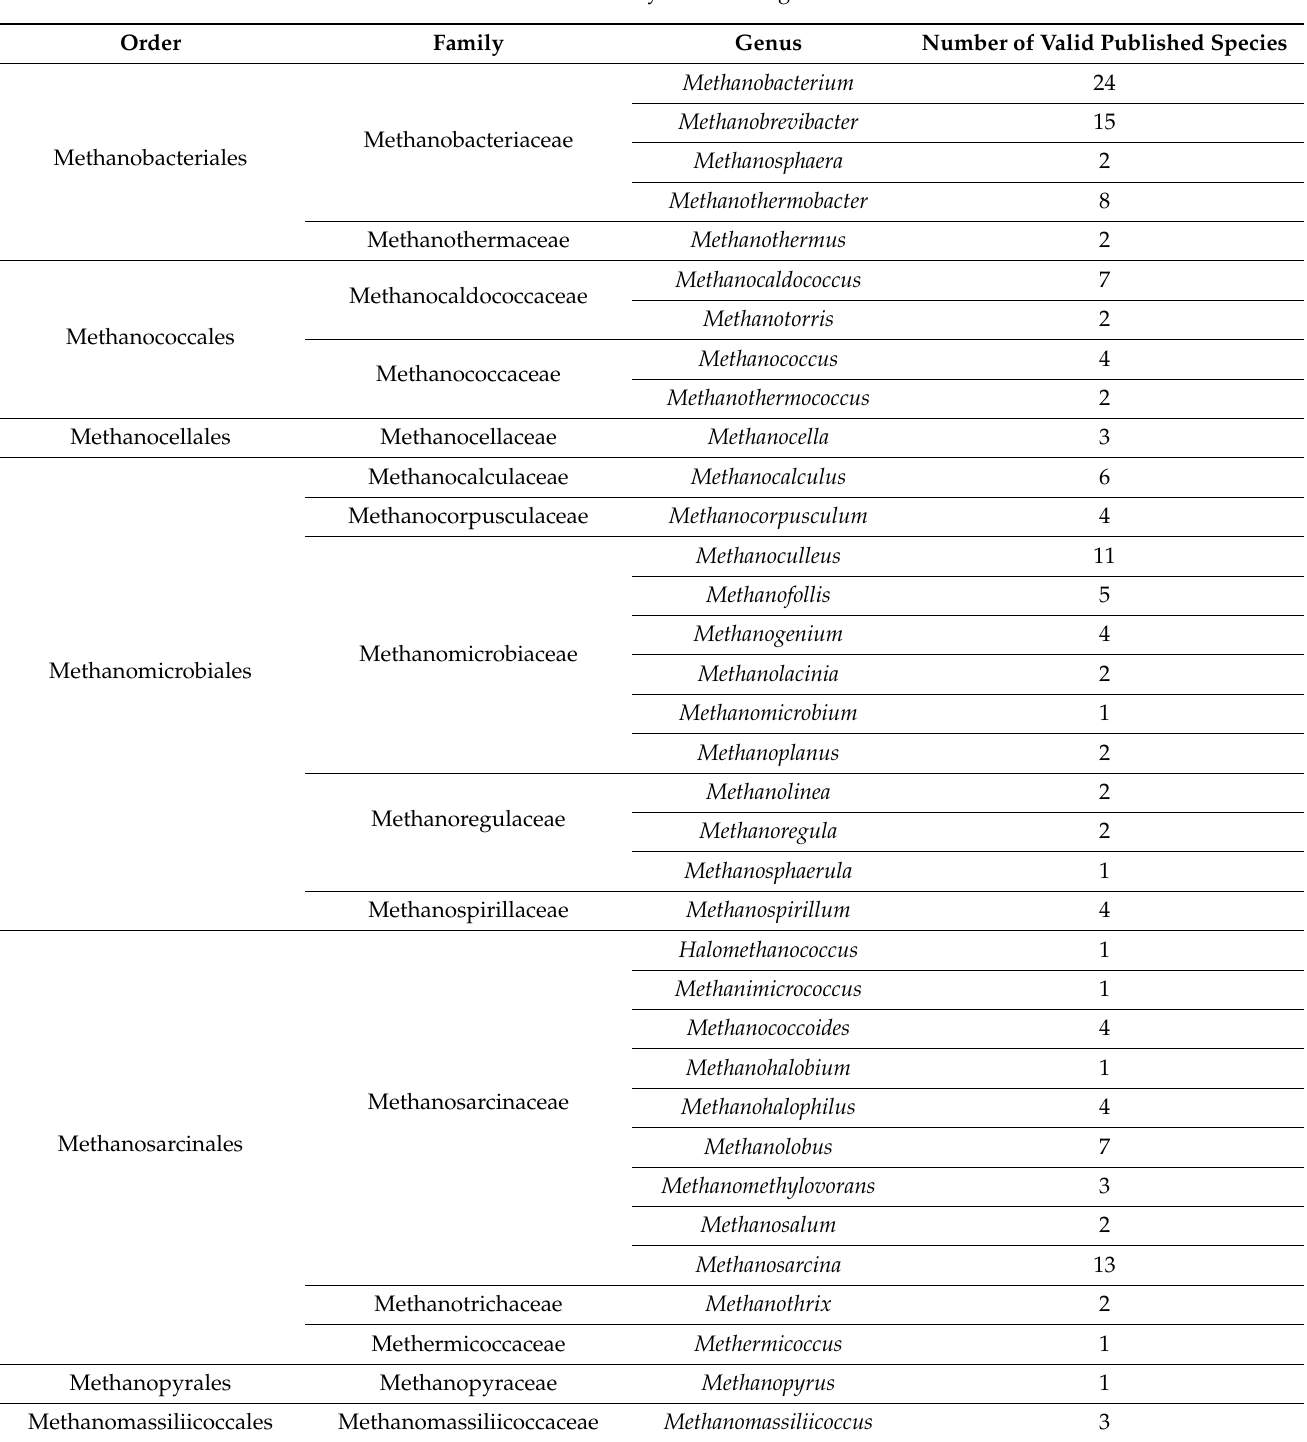
Table 2. Taxonomy of